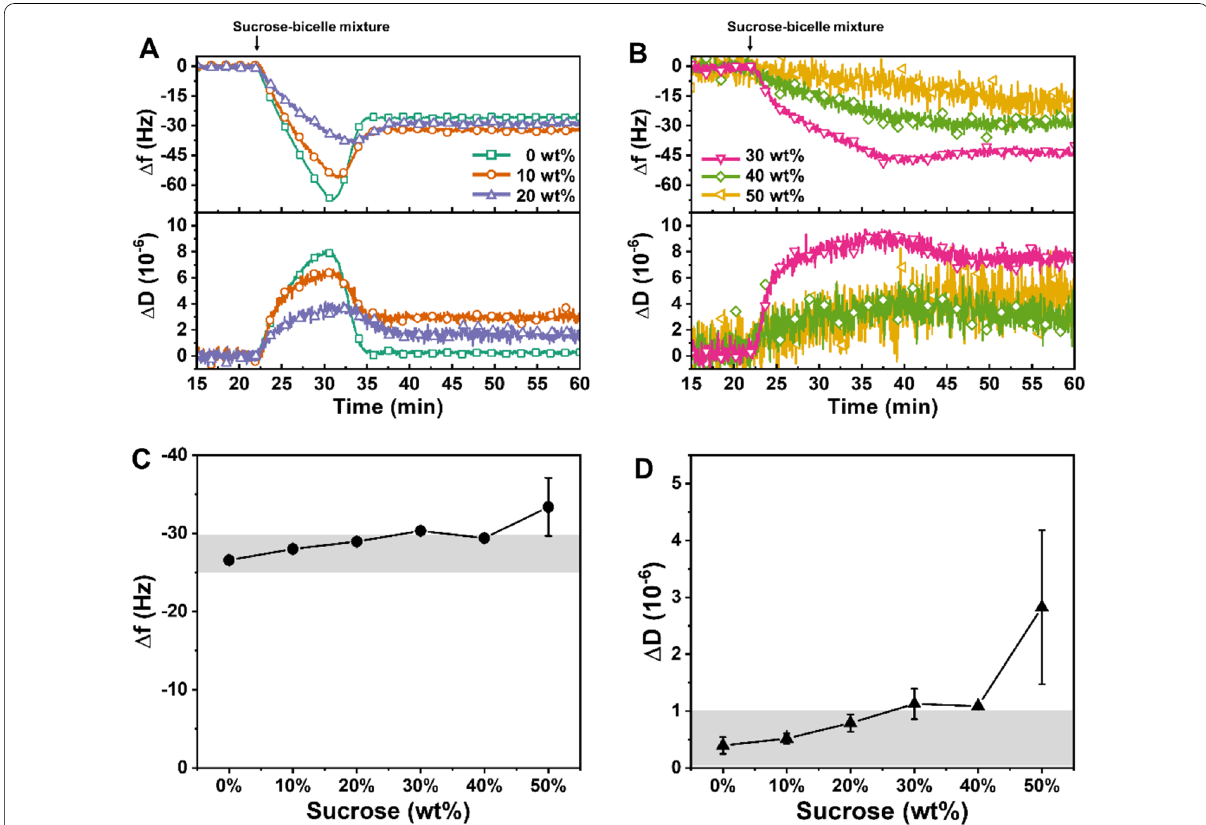
Fig. 1 QCM–D characterization of bicelle adsorption onto silica surfaces in mixtures containing various concentrations of sucrose. Changes in Δ f and Δ D shifts were monitored as a function of time to track the bicelle adsorption. The normalized kinetic profiles of Δ f and Δ D shifts were determined by subtracting the respective Δ f and Δ D shifts of A 0–20 wt% and B 30–50 wt% sucrose solutions. The column graphs present the final values of C Δ f and D Δ D shifts after buffer washing ( n 3, mean SD). The highlighted grey regions in the column graphs of final shifts denote = ± typical values of a complete